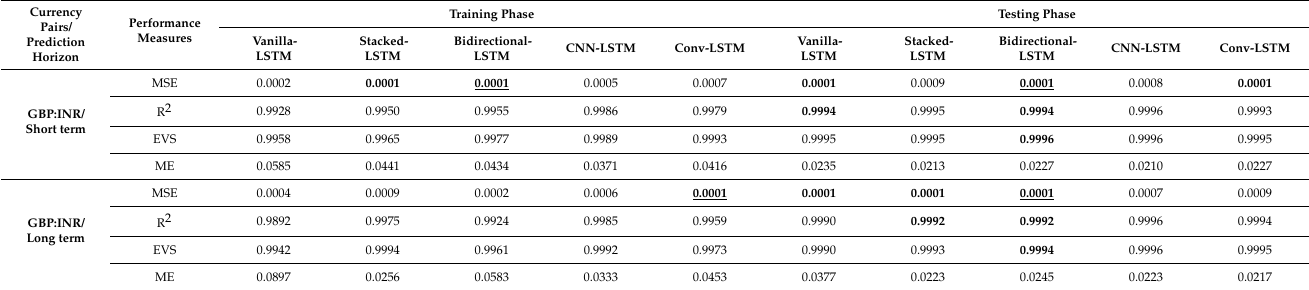
both short-term and long-term predictive Table 5. Recognition performance in training and testing phases for all three currency pairs and for